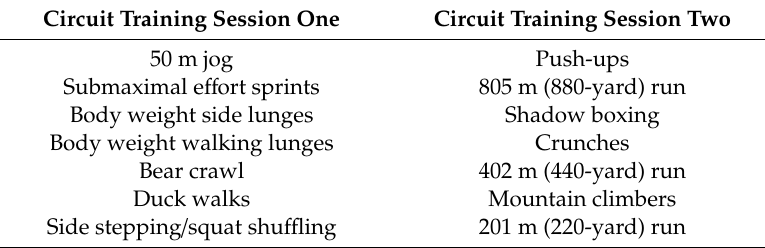
Table 1. List of exercises from the two circuit training